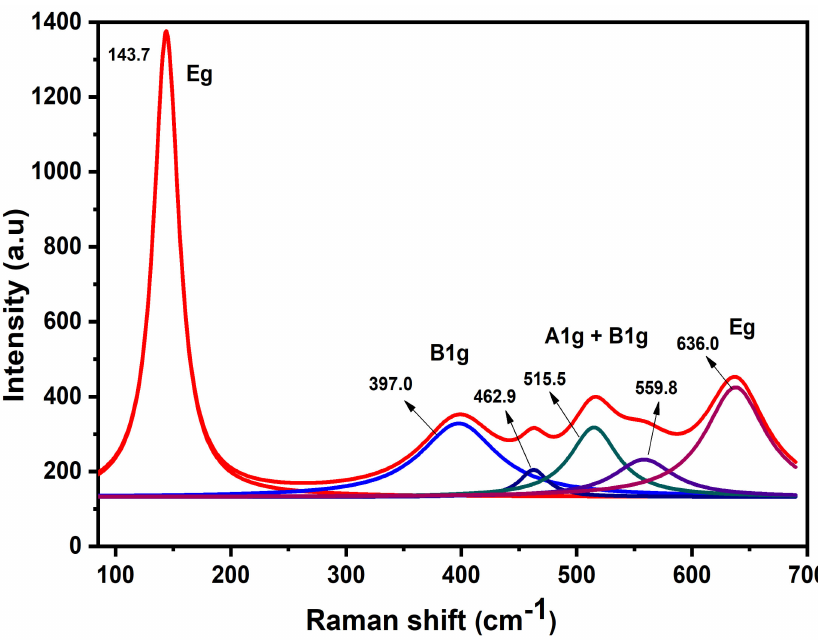
Figure 4. Raman spectroscopy of titanium dioxide nanoparticles. Figure 5 indicates the CT numbers of the different concentrations of TiO 2 -NPs that were scanned. With the addition of NPs concentration, the CT numbers of the solutions improve roughly linearly. The uncertainty of the measurements in the Hounsfield unit (HU) is given by the standard deviation. The CT numbers were ranging from 0 ± 3 HU (without NPs) to 283.7 ± 3 HU (0.235 g/mL). A value of (27.5 ± 3, 75.9 ± 3, 125.7 ± 3, 172.2 ± 3, 235.4 ± 3, and 283.7 ± 3) HU is given by a (0.02, 0.05, 0.1, 0.15, 0.2, 0.235) g/mL